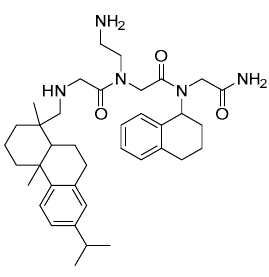
Figure 7. Structure of CHIR29498.